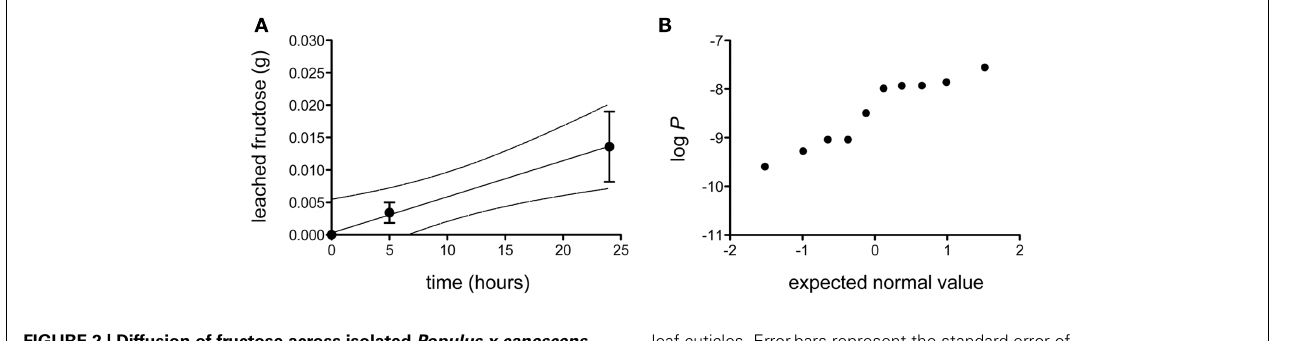
FIGURE 2 | Diffusion of fructose across isolated Populus x canescens leaf cuticles. (A) Accumulation of fructose (in grams) as a function of time at a donor concentration of 0.18gmL − 1 . Shown is the linear regression ( r 2 = 0.99) with 95% confidence intervals (broken lines) of the mean ( n = 10) diffusion of fructose over Populus x canescens